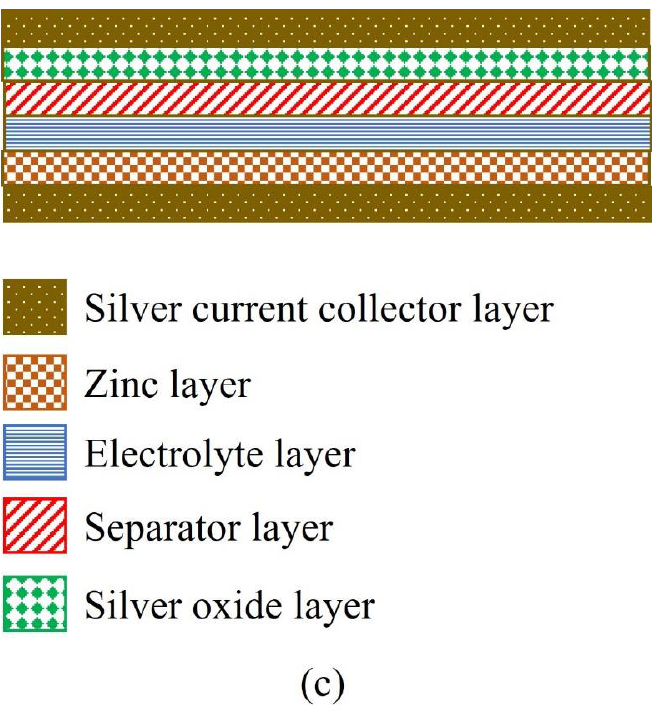
Figure 1. ( a ) Flow chart illustrating the flexible Ag 2 O-Zn battery fabrication procedure; ( b ) cross- sectional view of the corresponding printed layer at each fabrication step; and ( c ) the cross-sectional view of different layers in an assembled Ag 2 O-Zn pouch cell.